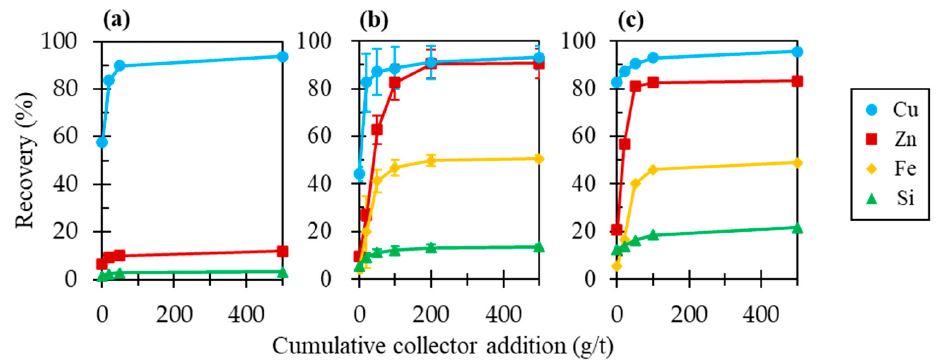
Figure 8. Flotation results of sphalerite and chalcopyrite ( a ) in the absence of pyrite and with zinc sulfate 1 kg/t, ( b ) in the presence of pyrite and zinc sulfate 1kg/t, and ( c ) in the presence of pyrite and zinc sulfate 10 kg/t. Note that the data at 100 and 200 g/t of collector in Figure 8a and those at 200 g/t of collector in Figure 8c were absent due to the lack of froth amounts for the XRF.